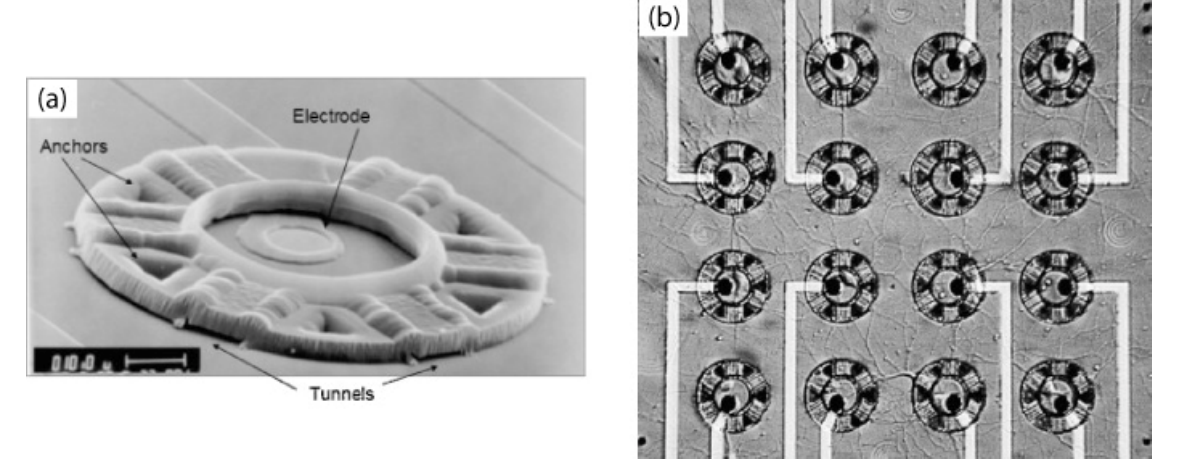
Figure 21. (a) SEM of the final neurocage design. The major parts of the neurocage are labeled. A neuron is placed in the central chimney region, near the electrode. Axons and dendrites are free to grow though the tunnels to synapse with other neurons. The cage is made out of 4 μ m parylene, a biocompatible polymer. Low-stress silicon nitride insulates the gold electrode and leads. Scale bar: 10 μ m. (b) 10 days old neuronal culture on chip. Neuron bodies (soma) are trapped in cages, with fine axonal processes outgrowth through the tunnels forming a rich network with surrounding neurons. Reprinted from reference [76]. Copyright (2008), with permission from Elsevier.